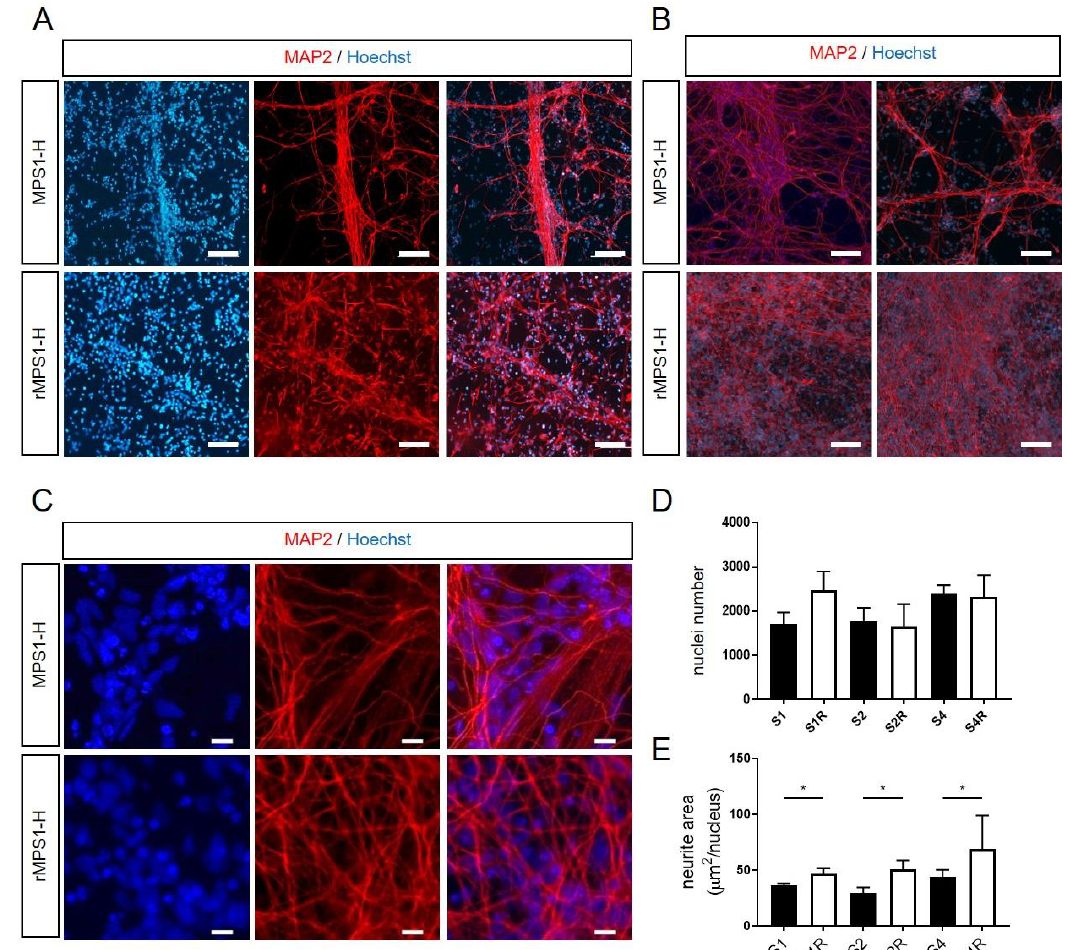
Figure 4. Analyze of neurite outgrowth of MPS1-H iPSCs-derived NSCs and rescued counterparts after 3 weeks of differentiation. ( A,B ) Defective neurite outgrowth of MPS1-H iPSCs-derived NSCs compared to rescued NSCs is revealed by MAP2 staining at low magnification (scale bars = 50 µm) and ( C ) high magnification (scale bars = 15 µm) after 3 weeks of differentiation. Nuclei was counterstained with Hoechst. ( D ) Automatic analysis quantified the number of nuclei and ( E ) determined the MAP2-positive neurite surface per nuclei in the different clones. Data are shown as mean ± SEM and were analyzed by independent samples t -test. * p < 0.01.